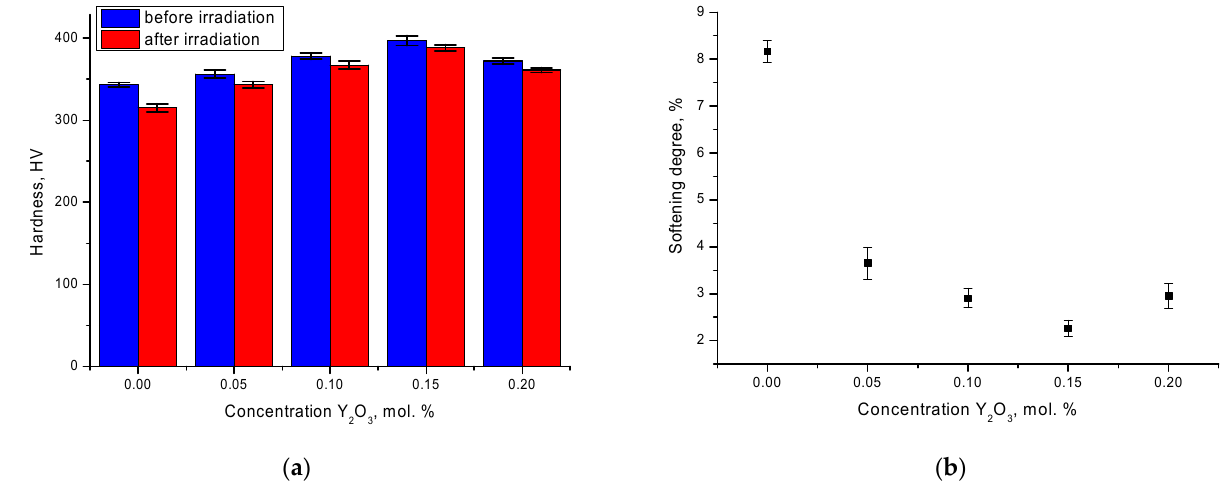
Figure 9. ( a ) Dependence diagram of hardness values before and after irradiation; ( b ) dynamics of change in the degree of resistance to softening of the surface layer of microparticles.